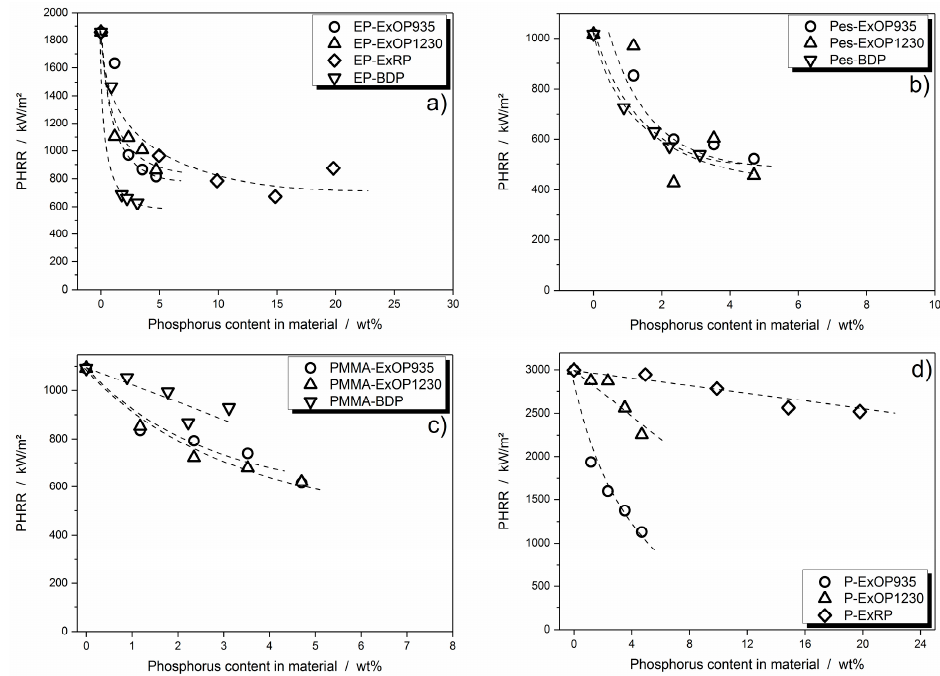
Figure 4. Peak of heat release rate (PHRR) of epoxy resin ( a ), polyester resin ( b ), PMMA resin ( c ) and paraffin ( d ) systems plotted against amount of phosphorus in the bulk material. The dotted lines are included as guides for the eye analogous to the findings from Brehme et al. for comparable materials [31]. The DGEBA/IPDA epoxy resin showed a very pronounced leveling off of flame retardancy effectiveness for all investigated flame retardants. This leveling off set in at around 10 wt % phosphorus content for RP, whereas the AlPi flame retardants Exolit OP935 and OP1230 already